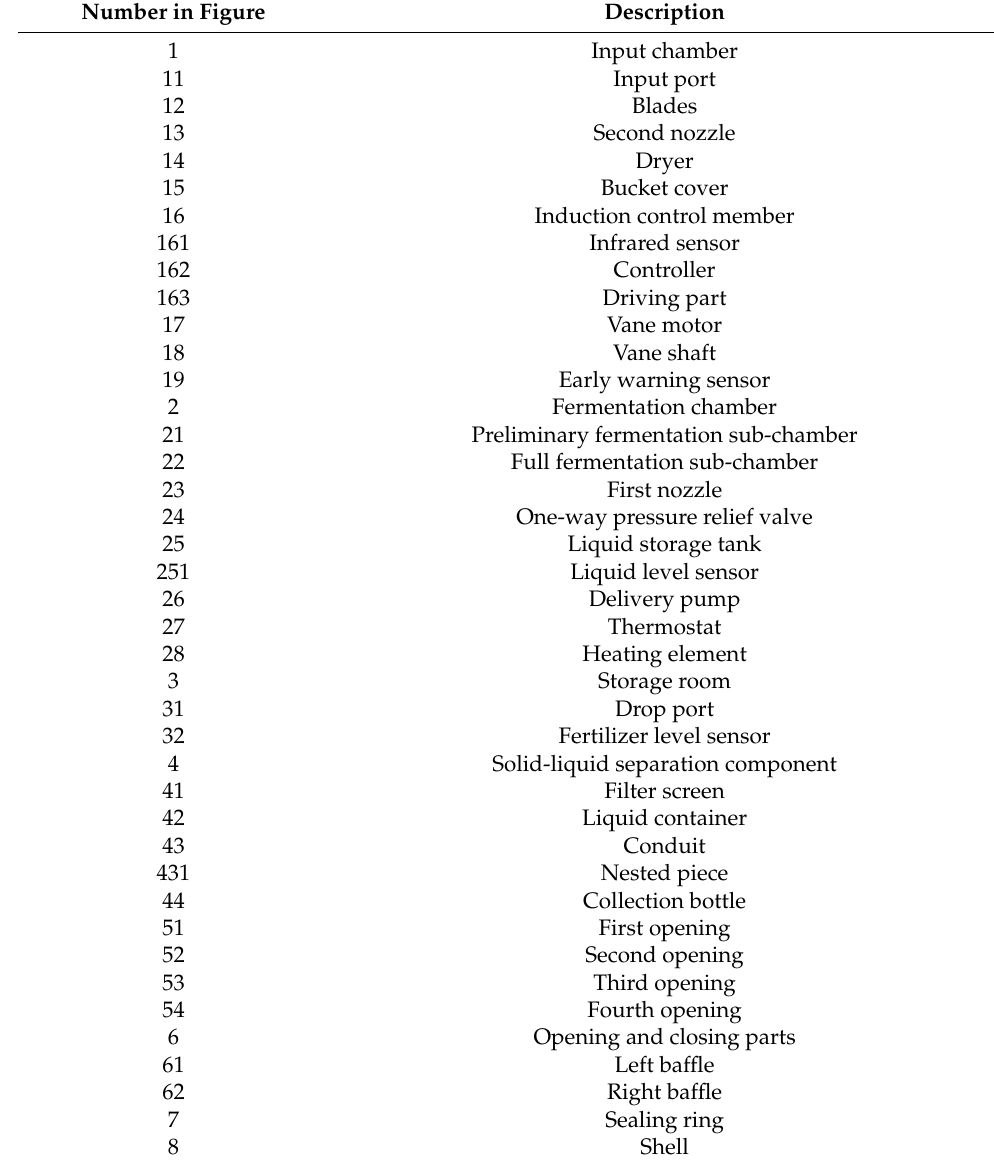
Table A6. An aerobic fully automated composter from CN208649153U [101].